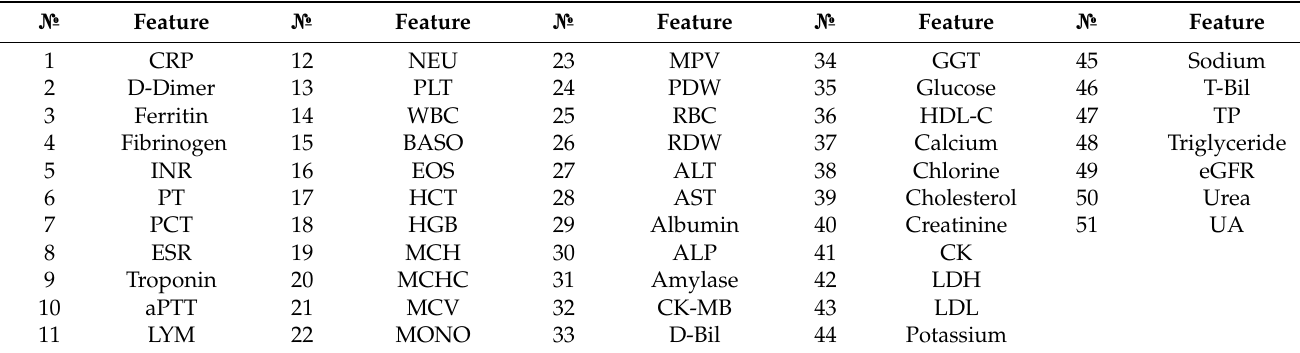
Table 1. Feature numbering for SARS-CoV-2-RBV1 datasets.